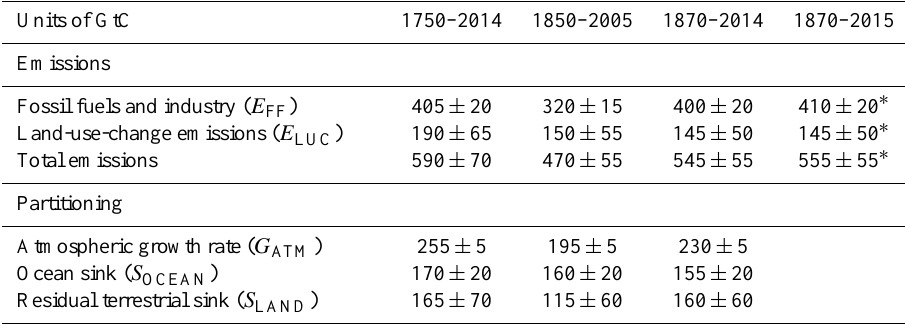
Table 10. Cumulative CO 2 emissions for the periods 1750–2014, 1870–2014, and 1870–2015 in gigatonnes of carbon (GtC). We also provide the 1850–2005 time period used in a number of model evaluation publications. All uncertainties are reported as ± 1 σ . All values are rounded to the nearest 5GtC as in Stocker et al. (2013), reflecting the limits of our capacity to constrain cumulative estimates. Thus some columns will not exactly balance because of rounding